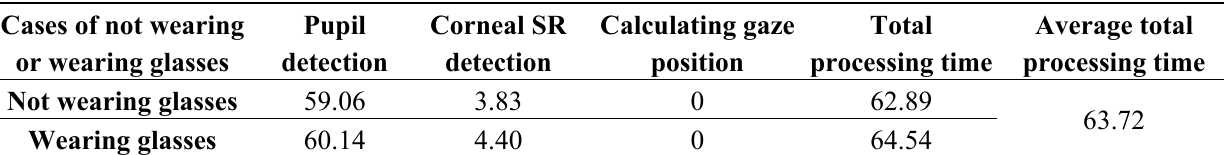
Table 11. The processing times for sub-modules in the gaze tracking system (units: